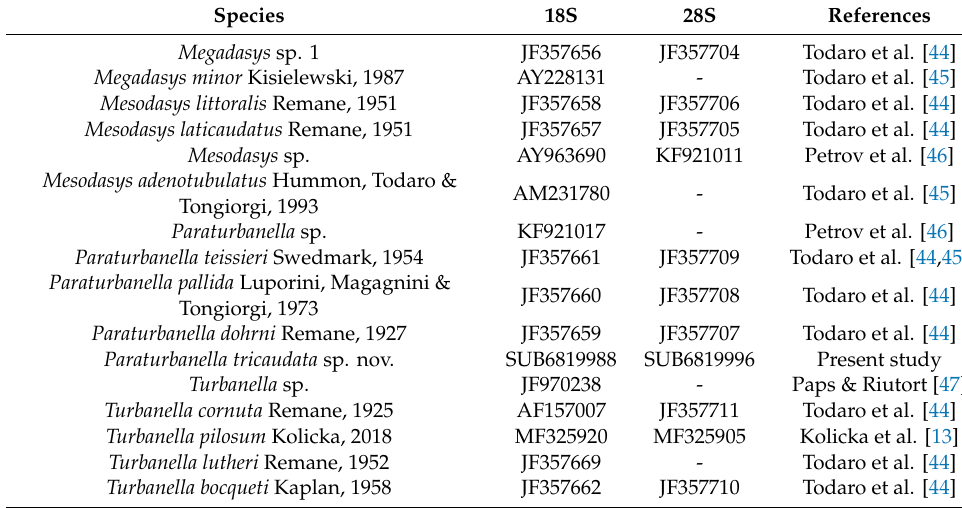
Table 1. Taxa of Gastrotricha included in this study, with respective GenBank accession numbers of 18S and 28S rDNA sequences.